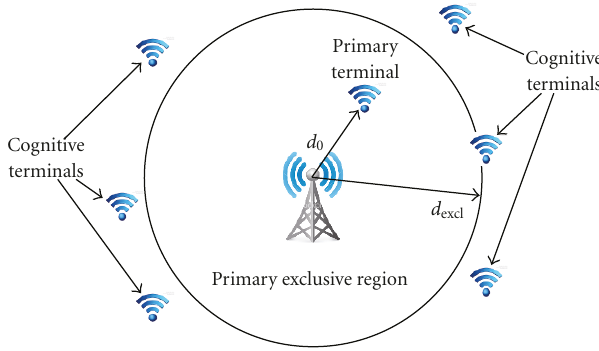
Figure 1: Cognitive network model: a single primary transmitter is placed at the center of a primary exclusive region (PER), with radius d excl , where its intended receiver is